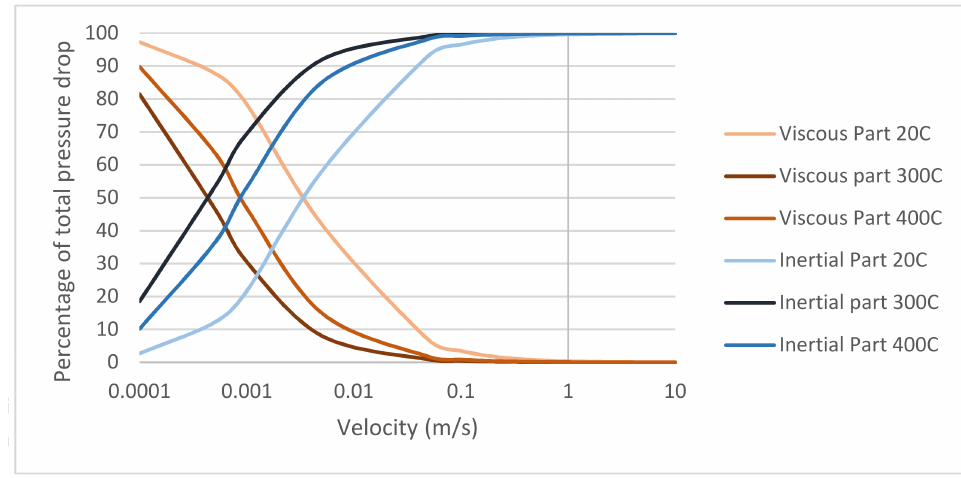
Figure 18. Change of inertial and viscous forces parts of the Ergun equation by